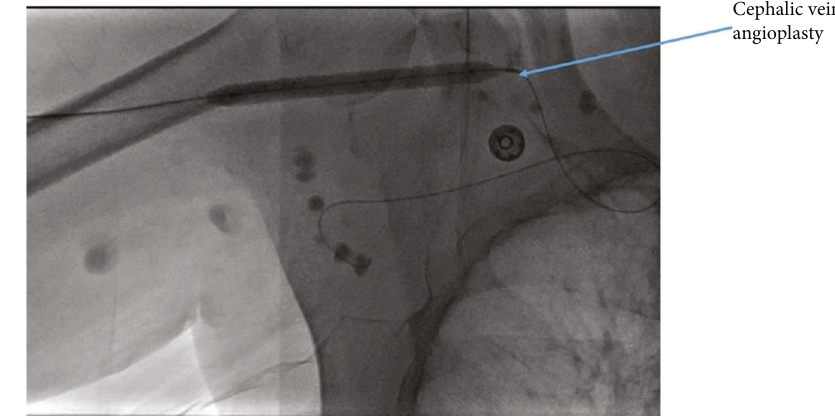
Figure 3: Out fl ow